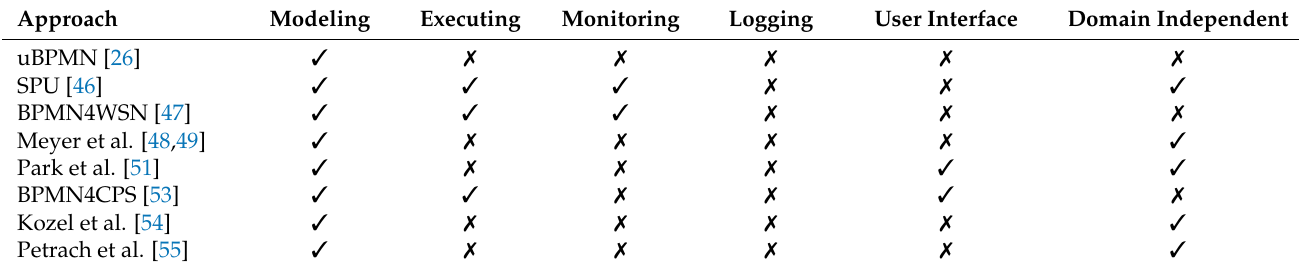
Table 1. Overview on related approach extending BPMN 2.0 for IoT-driven